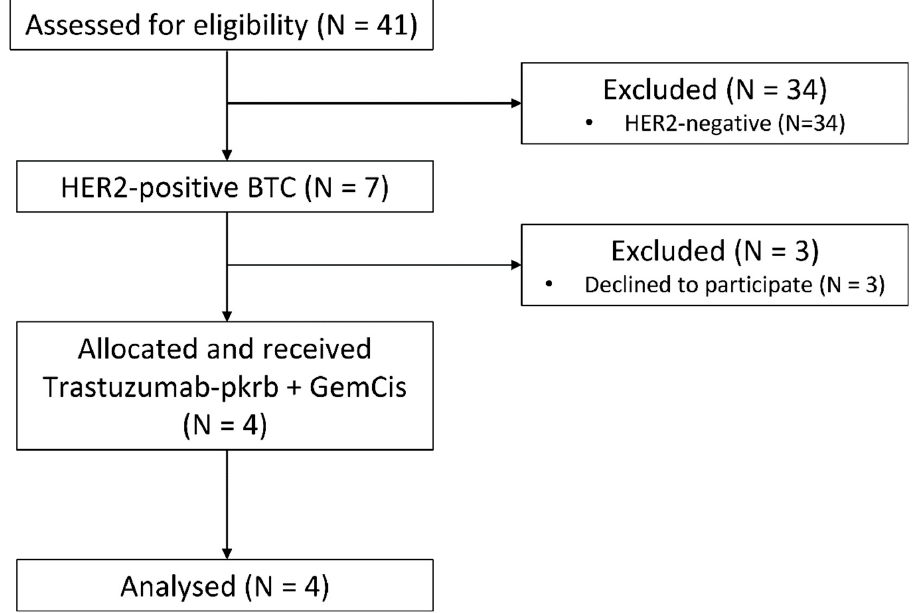
Figure 1. CONSORT diagram. Abbreviations: HER2, human epidermal growth factor receptor 2; BTC, biliary tract cancer; GemCis, gemcitabine and cisplatin. Table 1. Baseline